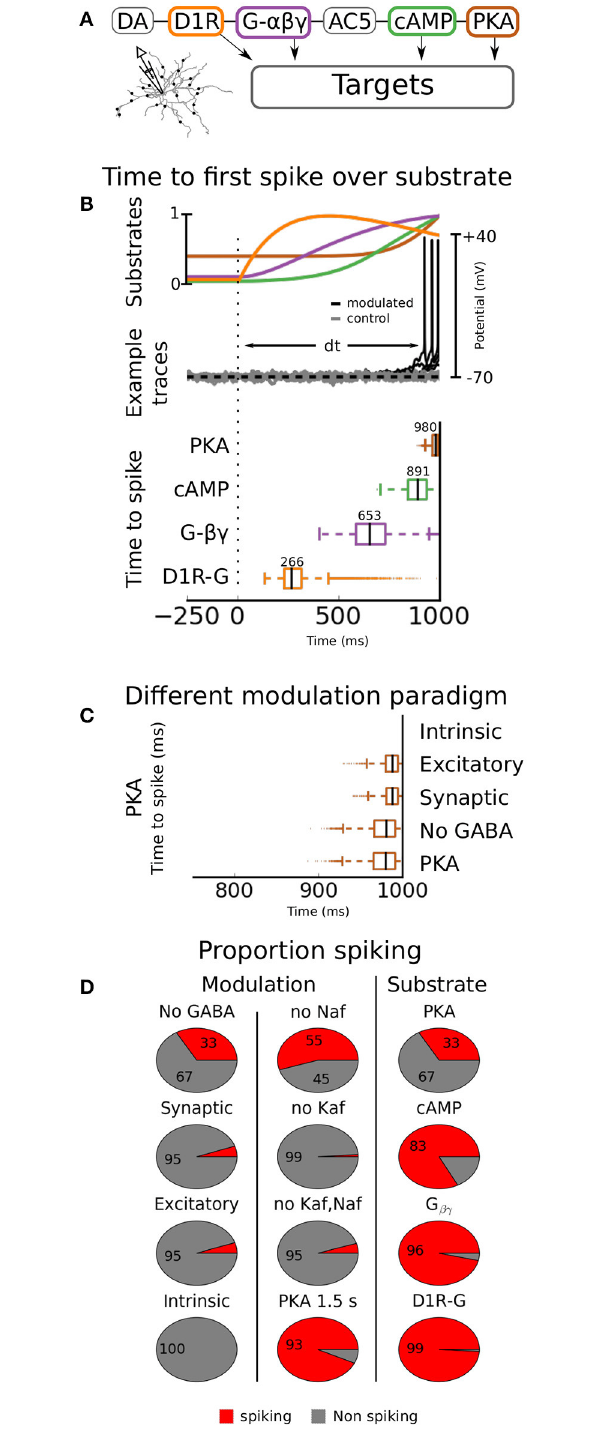
FIGURE 6 | Dynamic modulation. The timing aspects of the DA modulation is assessed by connecting the channel conductances to a DA transient. The transient follows an alpha function with 0.5 µ M amplitude and a time constant of 500ms. In (A) , the simulation setup is outlined, showing a simplified illustration of the intracellular cascade. The model is here driven using synaptic (Continued)